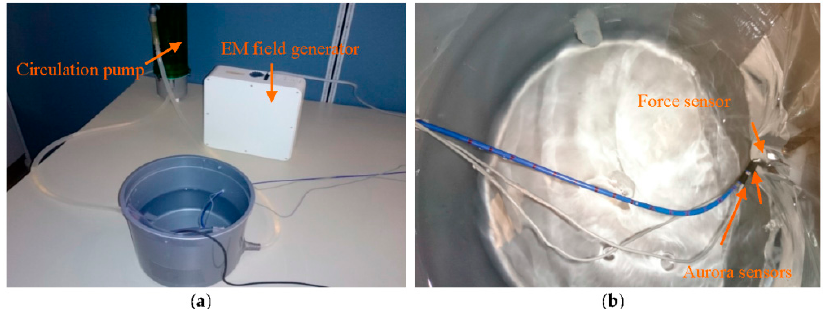
Figure 11. Experimental apparatus mimicking the intra-cardiac chamber with circulating flow for CFE: ( a ) The setup consisting of EM tracking system, circulation pump, ablation catheter and the force sensor; ( b ) Close-up view of the catheter and the EM sensors attached to it interacting with the force sensor.